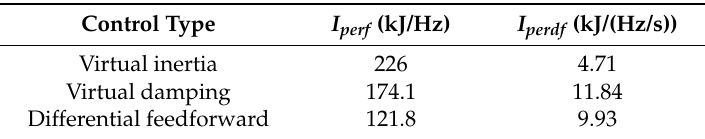
Table 4. Performance indexes for virtual inertia, virtual damping, and differential feedforward under load